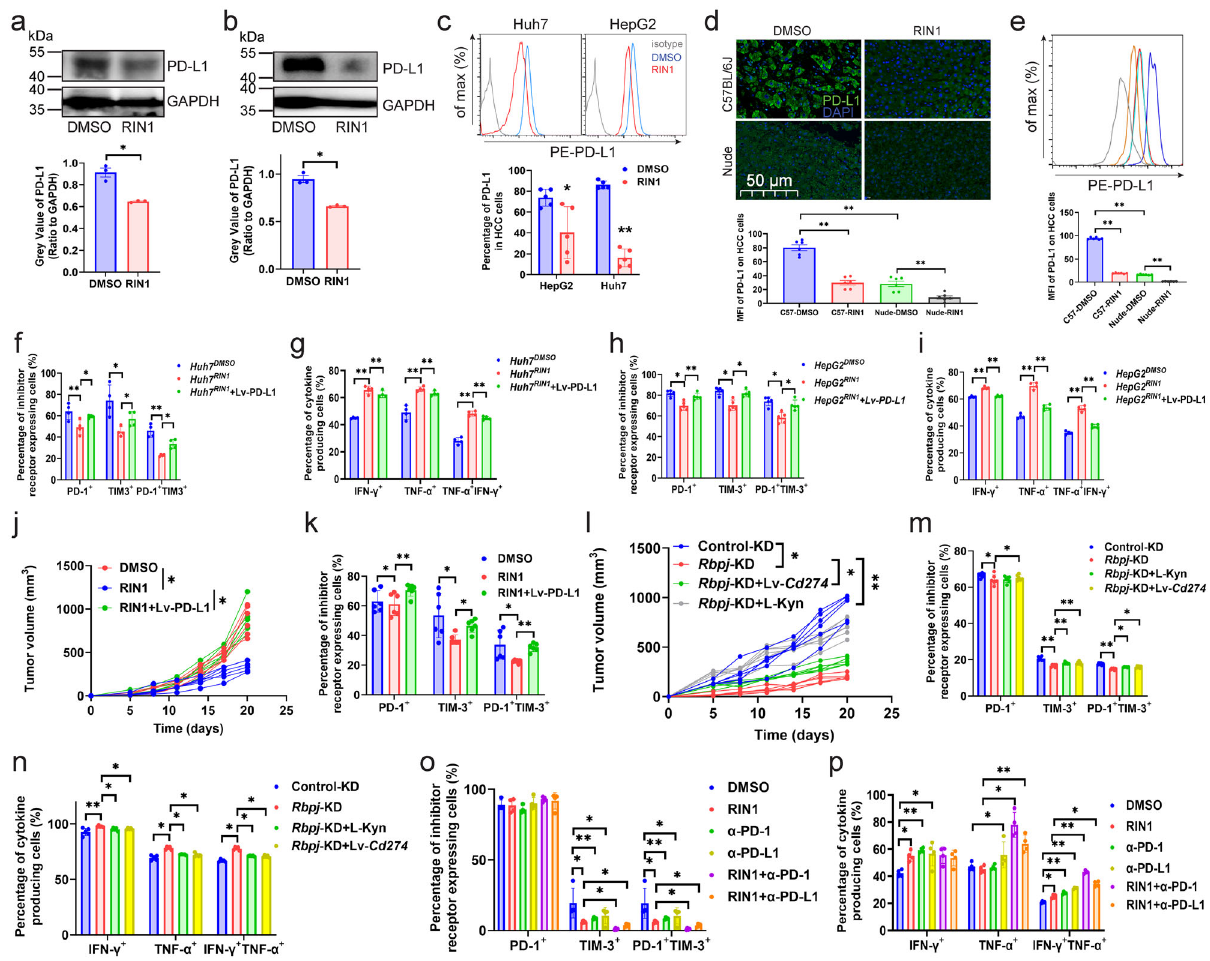
Fig. 6 RIN1 improved CD8 + T cell function through the PD-1/PD-L1 axis. a , b Immunoblot showing the effect of RIN1 (10 μ M) on PD-L1 protein expression in Huh7 ( a ) and HepG2 ( b ) cells ( n = 3). c Flow cytometry analysis of PD-L1 protein expression on the surface of Huh7 and HepG2 cells from control and RIN1 (10 μ M)-treated groups ( n = 5). d , e Immunohistochemistry and fl ow cytometry showing PD-L1 protein expression in HCC cells from subcutaneous tumor models ( n = 6). f – i Inhibitory receptor ( f , h ) and cytokine ( g , i ) expression on CD8 + T cells from control, HCC RIN1 , and HCC RIN1 + Lv- PD-L1 groups, HCC RIN1 included Huh7 RIN1 ( f , g ) and HepG2 RIN1 (h-i) ( n = 4). j , k Tumor growth curves ( j ) and inhibitory receptor expression on CD8 + T cells in tumors ( k ) from subcutaneous inoculation of wild-type Hepa1-6 cells, intraperitoneal injection of RIN1 (50 mg/kg) with subcutaneous inoculation of wild-type Hepa1-6 cells, and intraperitoneal injection of RIN1 with subcutaneous inoculation of Hepa1-6 cells overexpressing PD-L1 groups ( n = 6). l Tumor growth curves from control-KD, Rbpj -KD, Rbpj -KD + Lv- Cd274 , Rbpj -KD + L-kynurenine (30 mg/kg) groups ( n = 6). m , n Inhibitory receptor (m, n = 4) and cytokine ( n , n = 5) expression on CD8 + T cells from control-KD, Rbpj -KD, Rbpj -KD + Lv- Cd274 , Rbpj -KD + L-kynurenine (30 mg/kg) groups. o , p Flow cytometry analysis of the expression of inhibitory receptors ( o , n = 4) and cytokines ( p , n = 6) from DMSO, intraperitoneal injection of RIN1 (50 mg/kg), intraperitoneal injection of RIN1 with anti-PD-1 (50 mg/kg)/PD-L1 (50 mg/kg) antibodies groups. Mean ± SD. Statistical signi fi cance determined by paired two-tailed t -test ( a – p ). * P < 0.05; ** P <